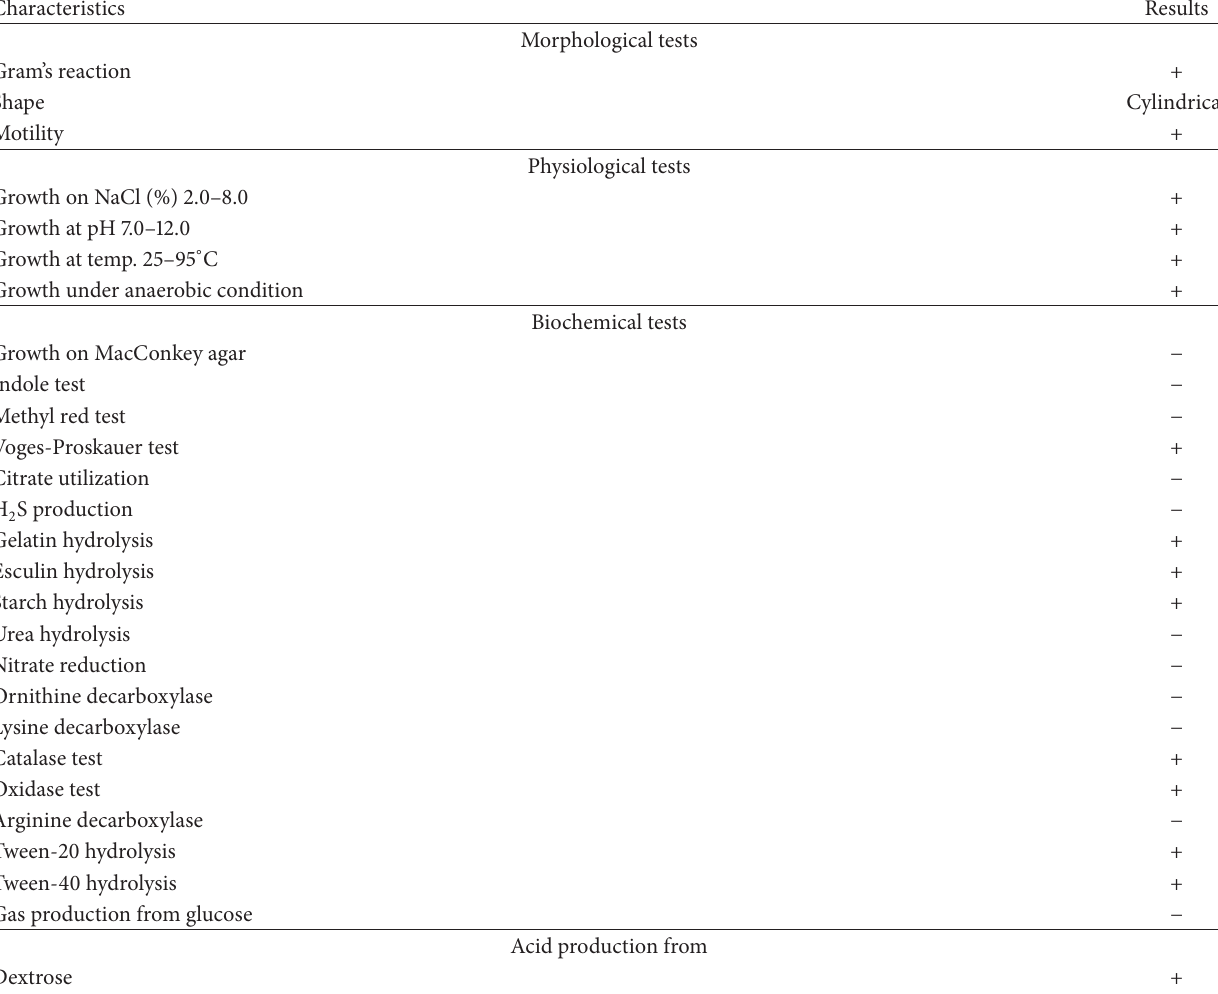
Table 1: Morphological, physiological, and biochemical characteristics of the selected RG-01